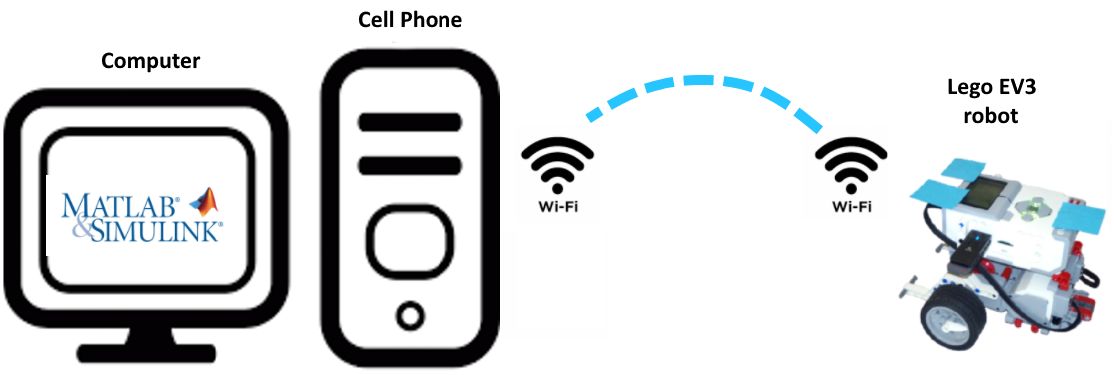
Figure 3. Experimental setup to test the platform.